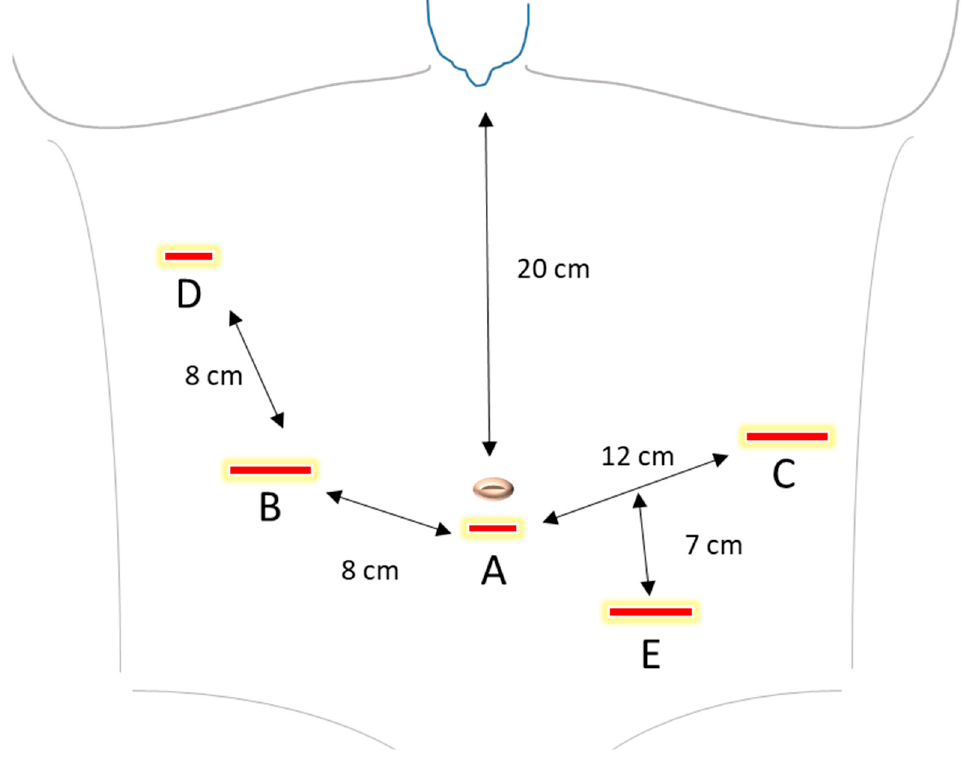
Figure 2. Trocar placement. A. Camera port (8 mm). B. 1. Robotic arm (12 mm). C. 2. Robotic arm (12 mm). D. 3. Robotic arm (8 mm). E. Assistant trocar (12 mm). The recommended distance between